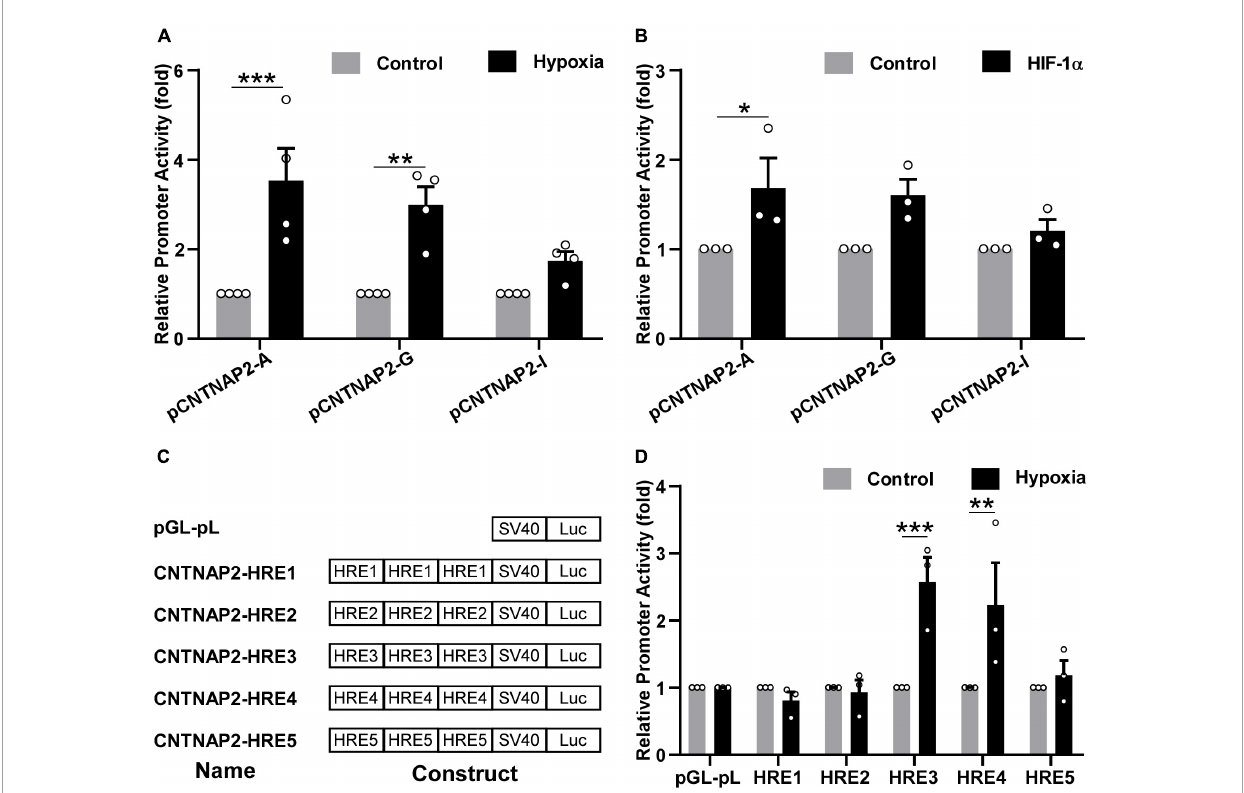
FIGURE5 Hypoxia upregulated CNTNAP2 promoter activity via functional HREs. (A) Hypoxia upregulated CNTNAP2 promoter activity. pCNTNAP2-A containing HRE1-5, pCNTNAP2-G containing HRE4-5, and pCNTNAP2-I without HREs were co-transfected with pCMV-Luc into HEK cells followed by hypoxia treatment (2% O 2 ) for 24 h. Hypoxia increased the promoter activities of pCNTNAP2-A and pCNTNAP2-G while showing little effect on pCNTNAP2-I ( n = 4, two-way ANOVA, treatment is considered as an independent variable, F (1, 18) = 38.05, p < 0.0001). (B) HIF-1 α upregulated CNTNAP2 promoter activity. pCNTNAP2-A, G, and I were co-transfected with HIF-1 α or vector and pCMV-Luc into HEK cells. Twenty-four hours post-transfection, cells were harvested for the dual-luciferase reporter assay. HIF-1 α enhanced the promoter activities of pCNTNAP2-A and pCNTNAP2-G but did not affect pCNTNAP2-I activity [ n = 3, two-way ANOVA, treatment effect, F (1, 12) = 13.98, p = 0.0028]. (C) Schematic diagram of CNTNAP2-HRE constructs. The name and construct of each plasmid were as illustrated. Triple HRE1-5 was cloned into the pGL-pL vector